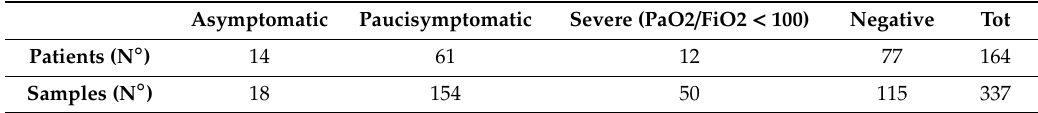
Table 1. Patient’s number and